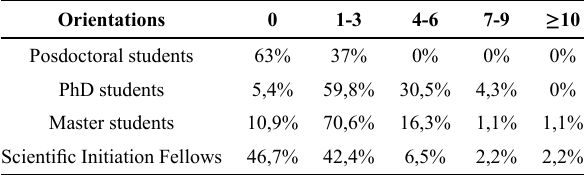
Table 4 - Number of people you guide.